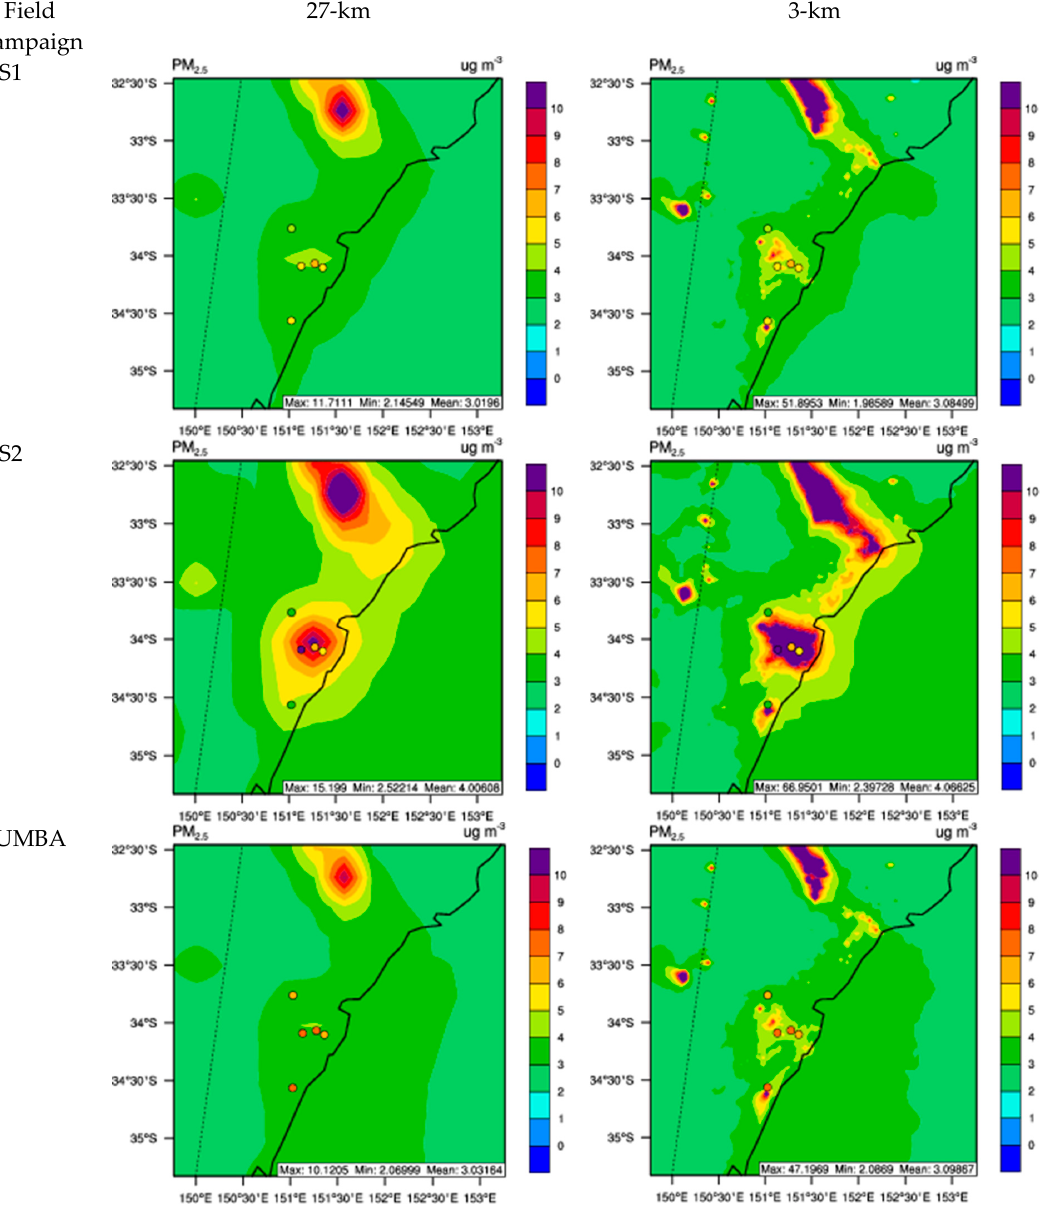
Figure 7. Simulated spatial distribution of surface concentrations of PM 2.5 overlaid with observations over the Greater Sydney area (d04). All simulation results are based on WRF/Chem-ROMS.